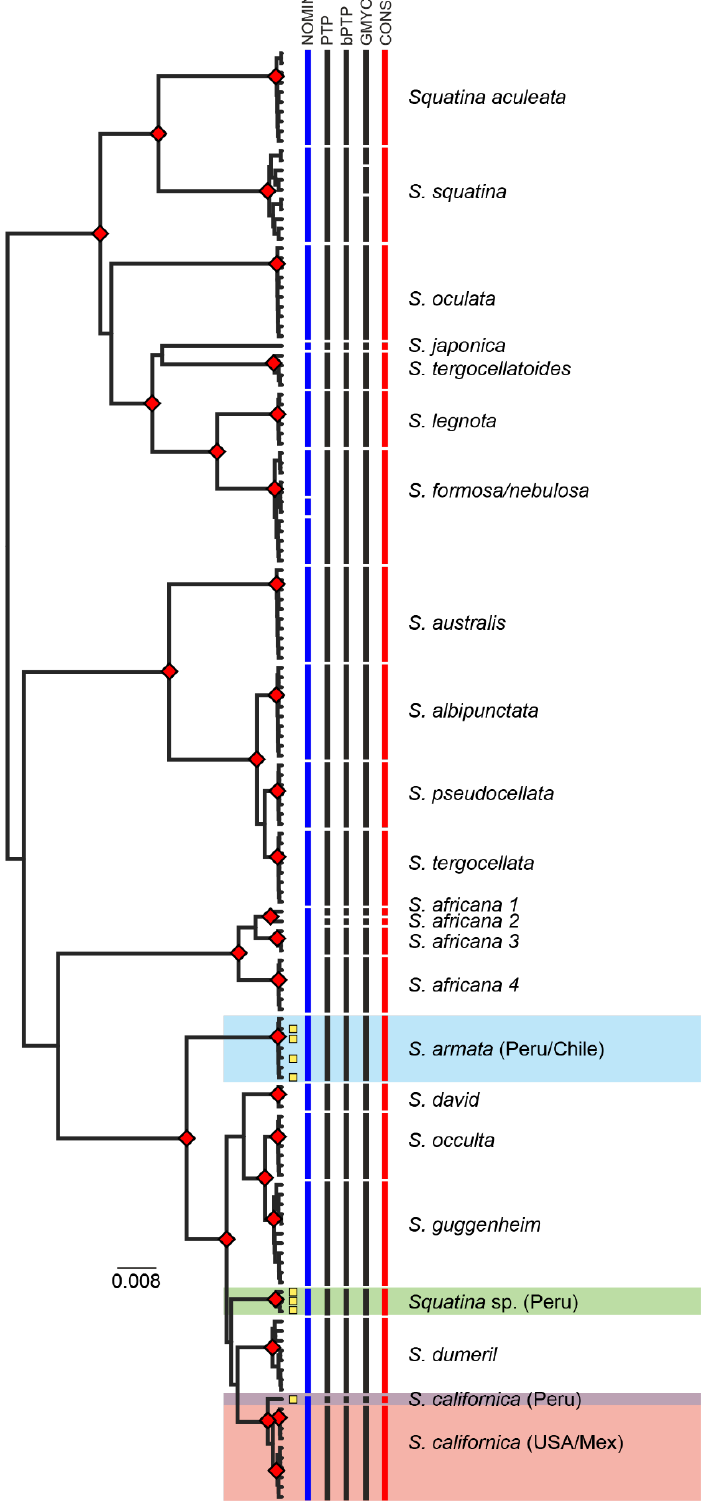
Figure 3. Bayesian tree showing the clustering of the MOTUs obtained by the species delimitation analyses (PTP, bPTP, and GYMC) and the consensus analysis. The red diamonds indicate nodes with supports higher than 0.9 Bayesian posterior probability. The scale bar indicates nucleotide substitutions per site. Samples from the Eastern Pacific Ocean are delimited by squares. Yellow squares indicate samples from northern Peru collected in this